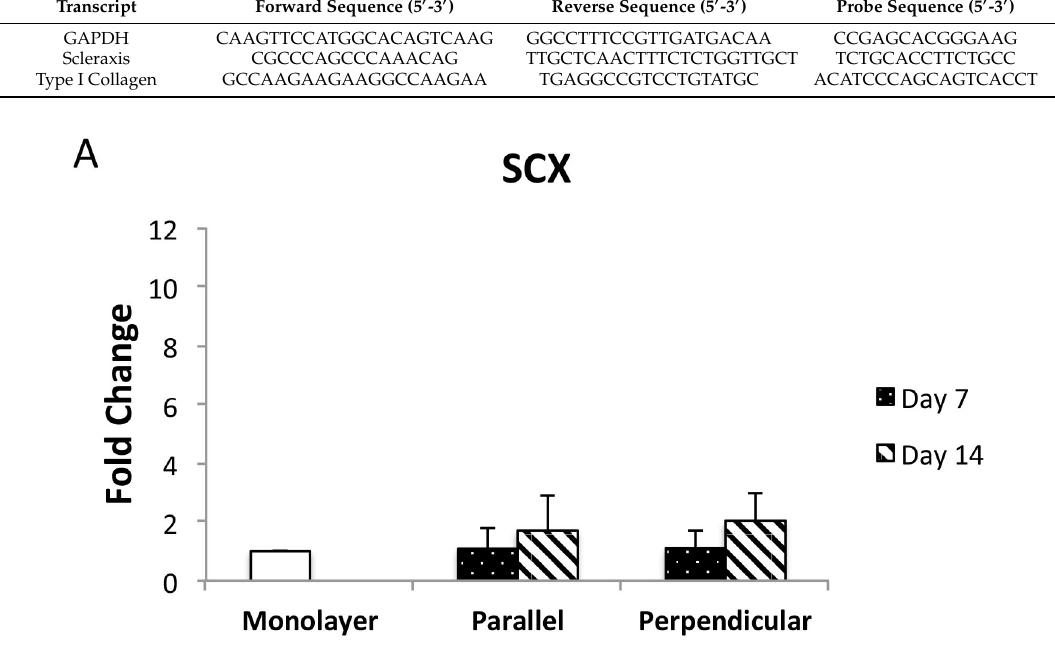
Figure 6. qPCR of MSCs from aligned scaffolds. Gene expression analysis of scleraxis ( A ) and type I collagen ( B ) from equine bone marrow MSCs collected from monolayers, aligned parallel scaffolds, and aligned perpendicular scaffolds on days 7 and 14. Genes were normalized to GAPDH (Glyceraldehyde 3-phosphate dehydrogenase). Gene expression of MSCs from scaffold designs is relative to monolayer controls. p -values ≤ 0.05 were considered significant. Error bars represent SEM. 3.4. ECM Production Increased over Time Extracellular matrix production was evaluated through biochemical analysis of collagen and GAG content in the media. We found the average collagen content to increase ( p = 0.0293) between days 1, 7, and 14, regardless of fiber orientation (Figure 7A). We also found the GAG deposition to increase over time in all three groups (monolayer, parallel, and perpendicular). There was an increase in GAG production between days ( p < 0.0001) and an increase between all days and fiber orientation ( p = 0.0038). In addition to the gene expression data, this increase in matrix deposition is indicative of tendon development.